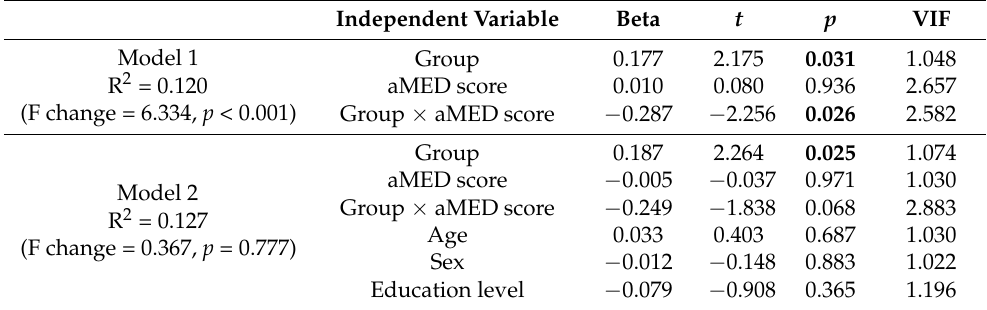
Figure 2. Correlations between the aMED score and BMI in subjects with schizophrenia and healthy controls. healthy controls. Table 3. Linear regression analysis for the association between BMI and the aMED